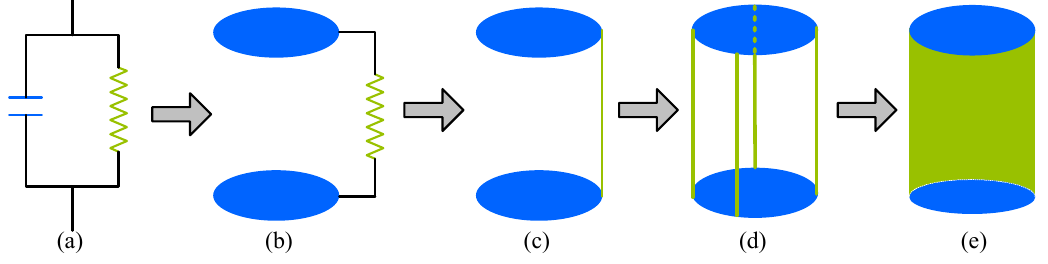
Figure 7. Evolution of the resonant cavity. ( a ) LC resonant circuit; ( b ) spacing the two plates of the capacitor; ( c ) reducing the number of turns of the inductor; ( d ) several parallel straight wires; ( e ) a closed